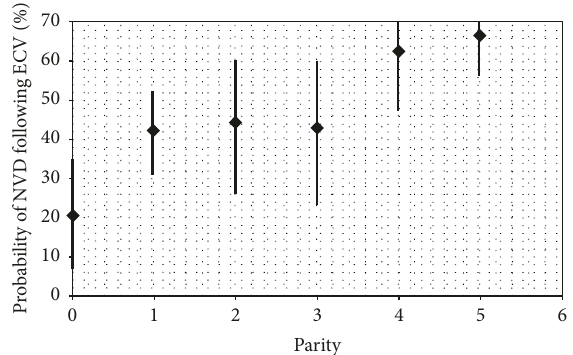
Figure 2: Parity versus probability of cephalic vaginal delivery following ECV. Diamond denotes calculated probability of cephalic vaginal delivery for a given